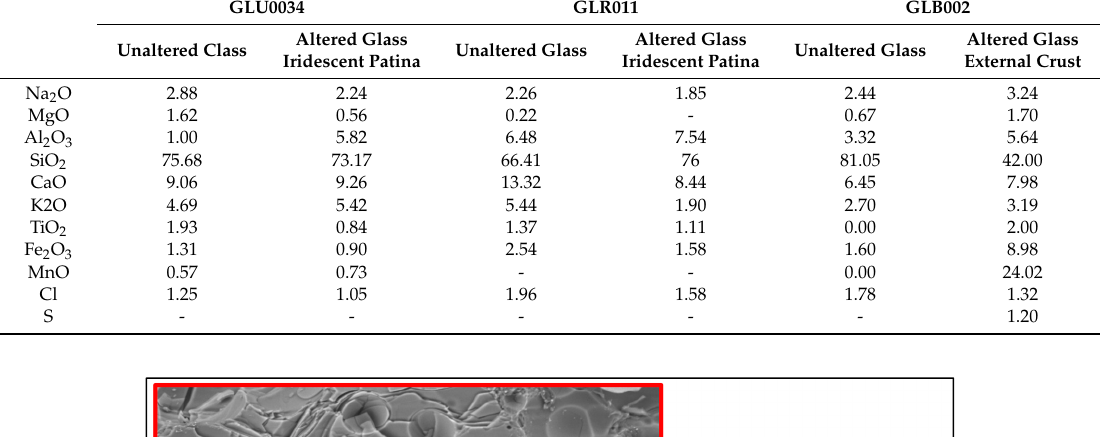
Table 2. SEM-EDS semi-quantitative analyses (wt%); for each oxide and element, the percentage is calculated as mean value over three measurements on two di ff erent areas of the same sample; for all the detected elements and oxides the standard deviation was lower than 5%.